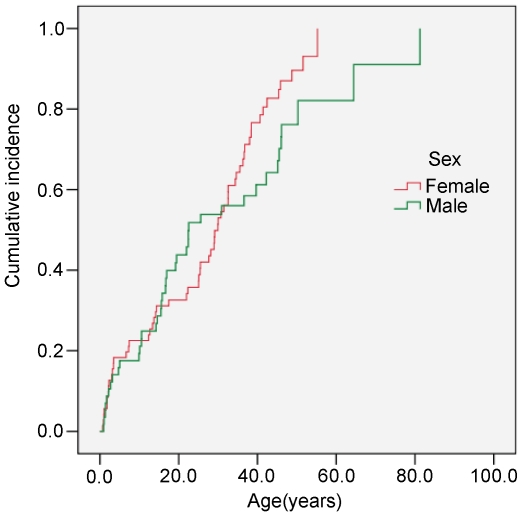
Kaplan-Meier estimated cumulative incidence for cancer in carriers of a p53 germline mutation by sex.Observations included 101 males and 112 females (log-rank test P = 0.0057).